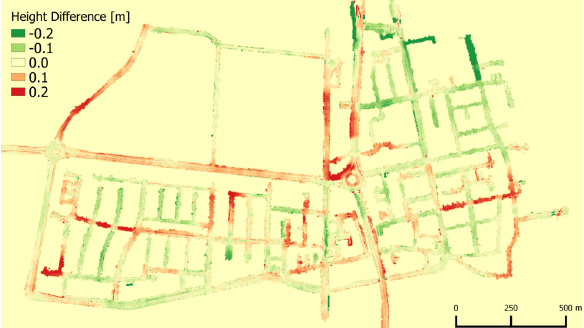
Figure 11. Difference between mobile mapping DTM and